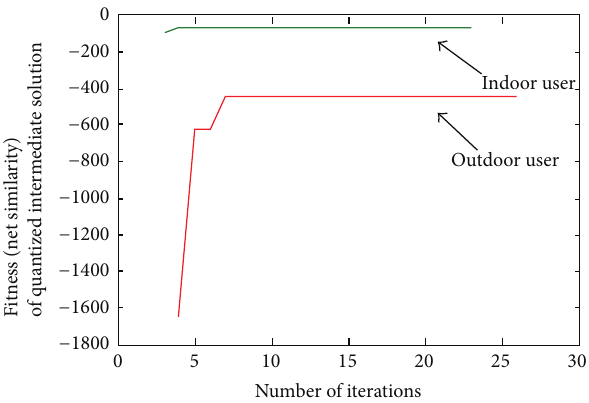
Figure 8: Fitness of AP clustering algorithm for indoor and outdoor